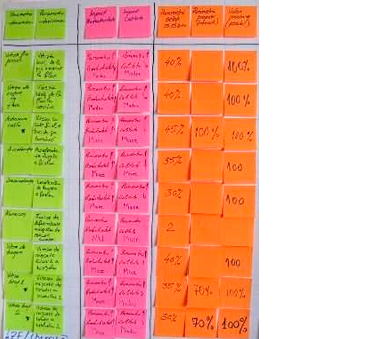
Figure 5. The flow of information in the daily analysis of defects.